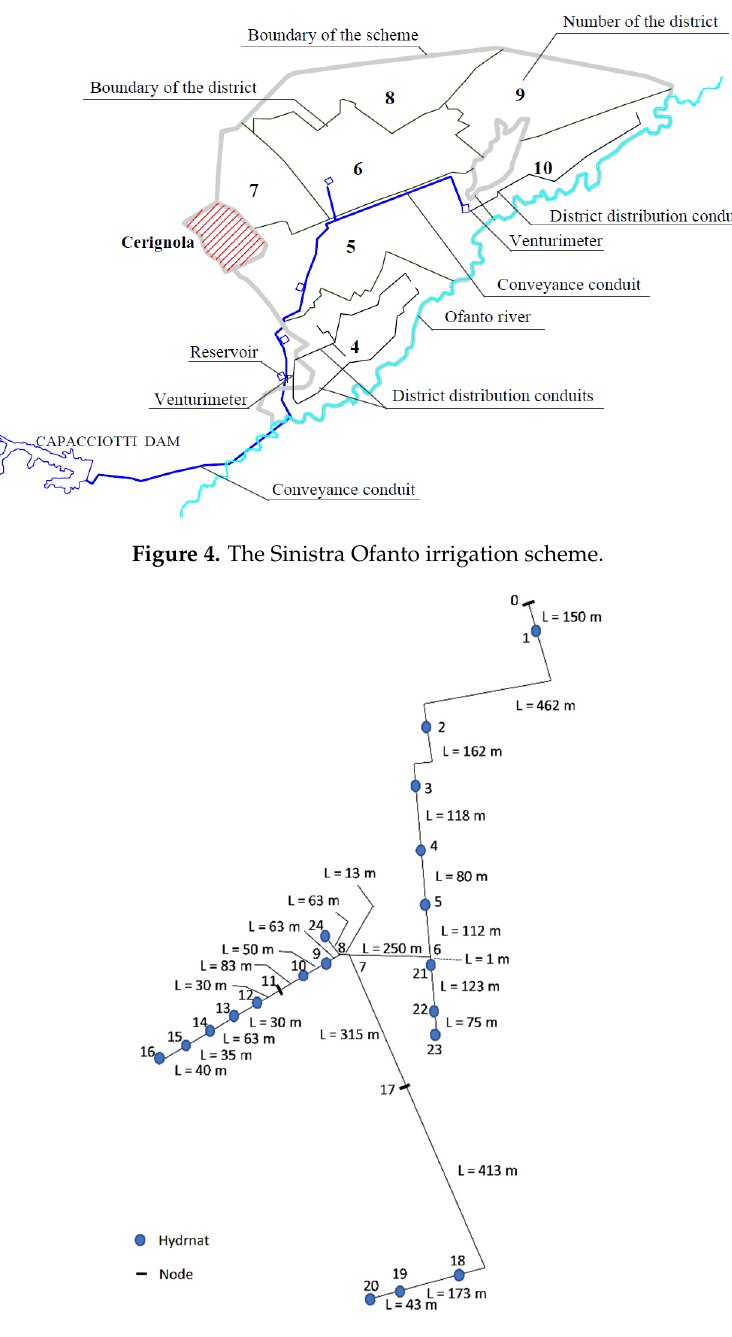
Figure 5. Layout of the network (sector 25).